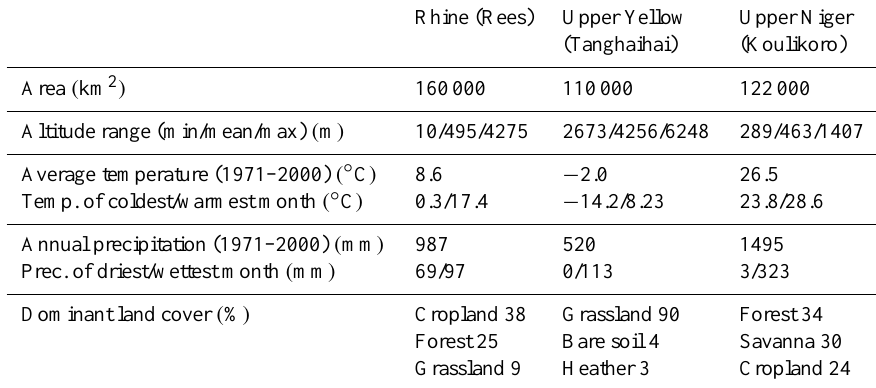
Table 1. Characteristics of the three river